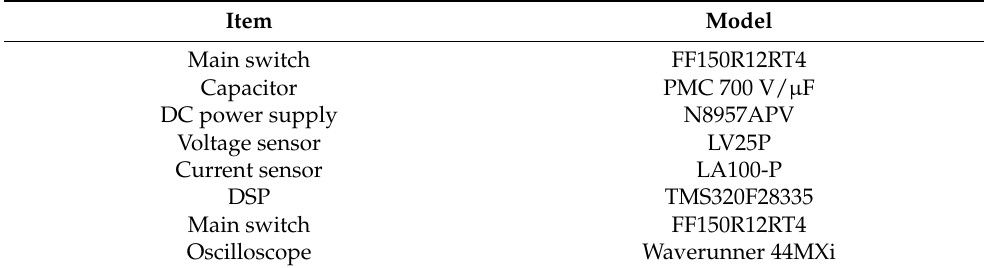
Table 4. Specifications of the measurement sensors and